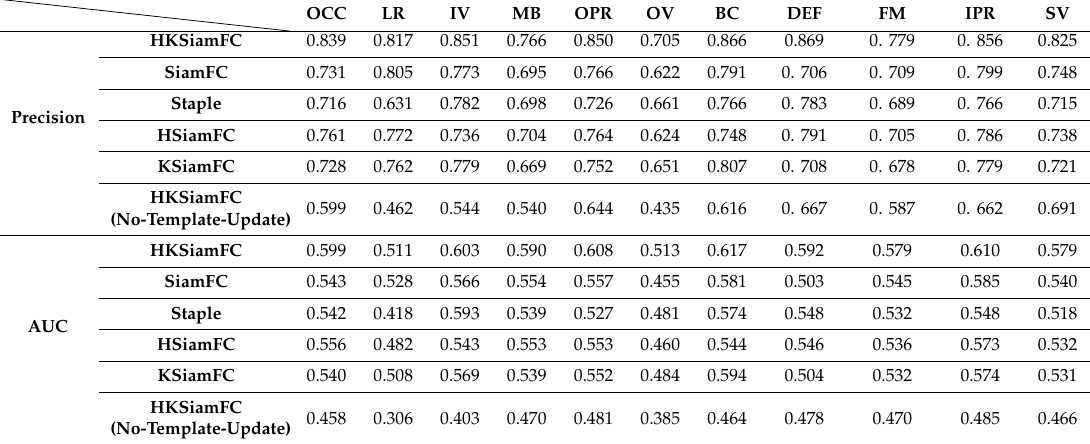
Table 1. Six trackers’ average precision values and average Area Under Curve (AUC) values in 11 di ff erent